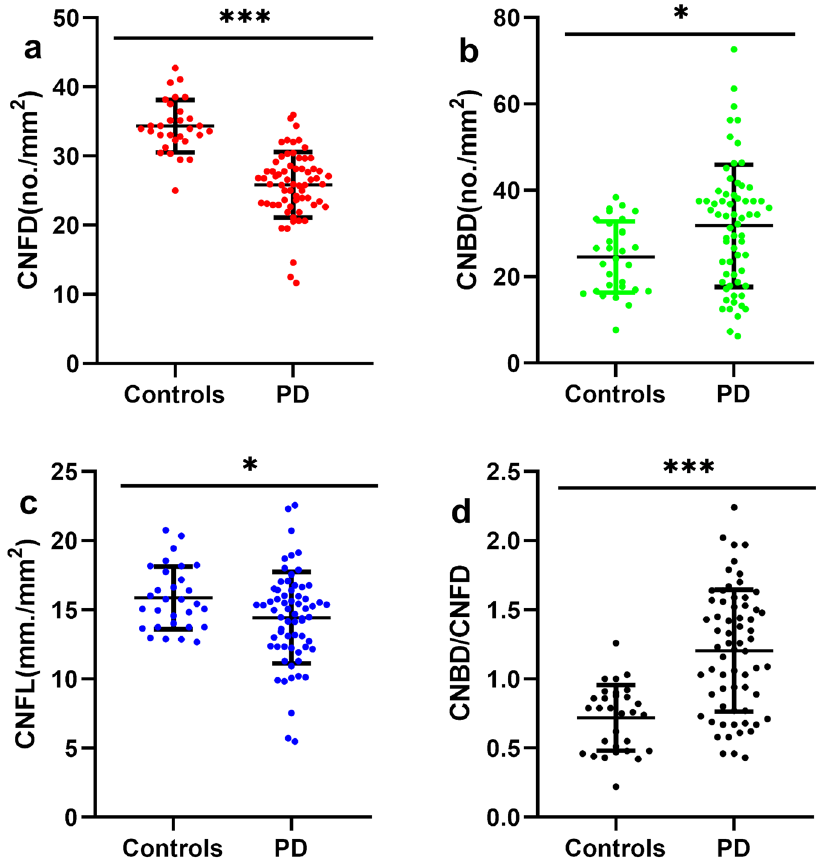
Fig. 1 Corneal nerve fi ber parameters in controls and patients with PD. CNFD and CNFL were decreased ( a , c ) and CNBD and CNBD/CNFD ratio were increased ( b , d ) in PD as compared to the control group with independent samples t -test. Errors bars represent mean ± standard deviation (* P < 0.05, ** P < 0.01, *** P < 0.001). Abbreviations: PD Parkinson ’ s disease, CNFD corneal nerve fi ber density, CNBD corneal nerve branch density, CNFL corneal nerve fi ber